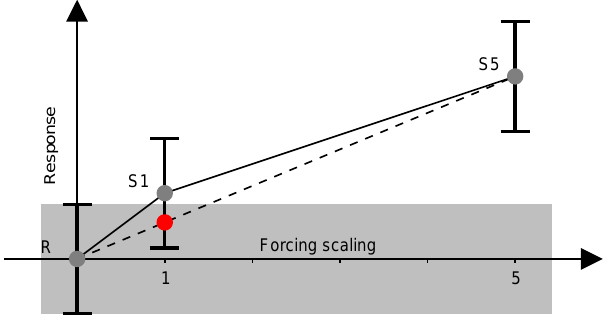
Fig. 5. Schematic representation of the impact of ensemble size and amplification of the forcing on the signal-to-noise ratio. The re- sponse (y-axis) is represented as a function of the size of the forcing (x-axis) in (R) a reference simulation, (S1) a simulation including once the forcing from a transport sector, and (S5) a simulation in- cluding 5 times the forcing from that transport sector. The black vertical bars indicate the uncertainty on the experiments best es- timates. Increasing the ensemble size reduces these uncertainties. Note that due to non-linearity, the best estimate based on an ampli- fication of the forcing (red dot) might be different from the actual impact (grey S1 dot).